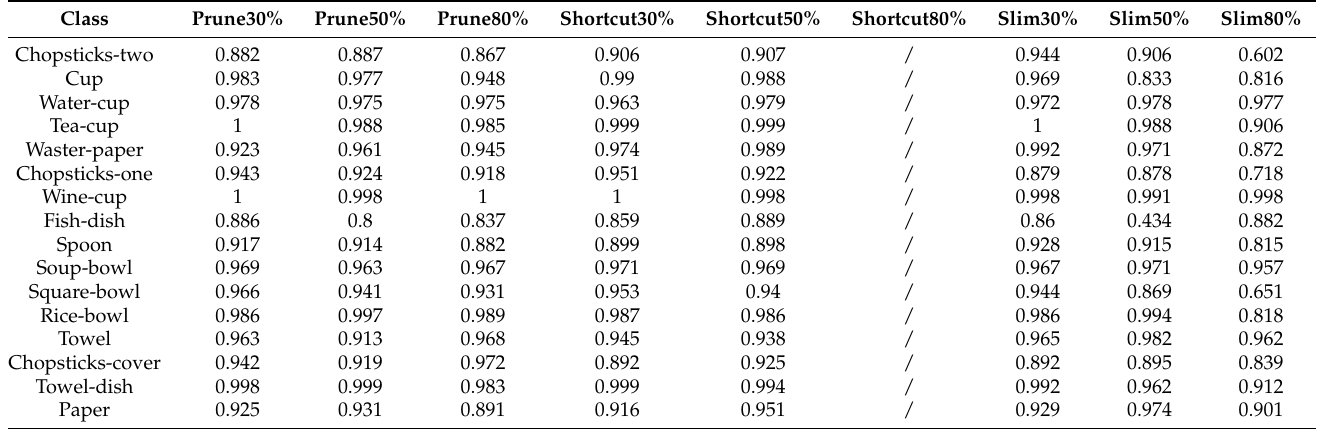
Table 6. Detection accuracy using sparse training Method B on FPGA.